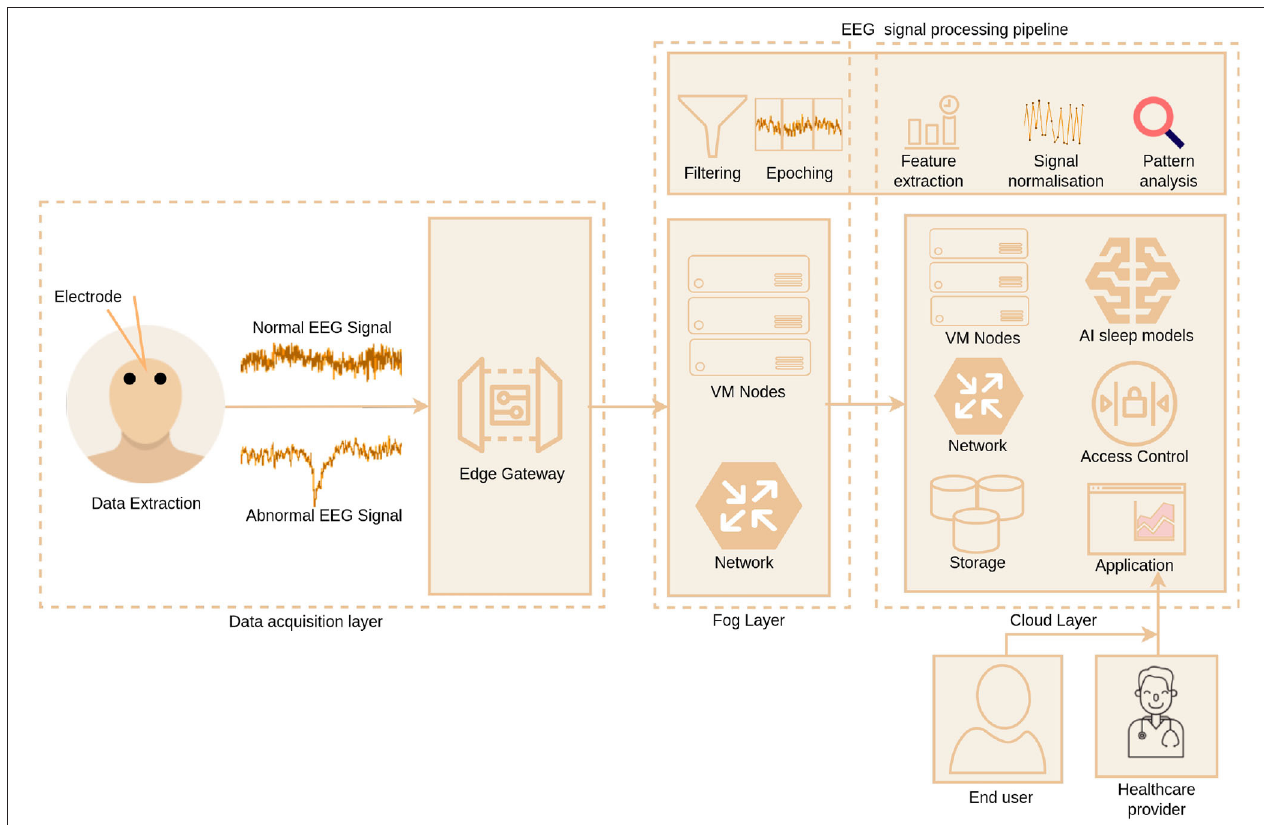
FIGURE 1 | Overview of sleep data extraction and analysis using cloud